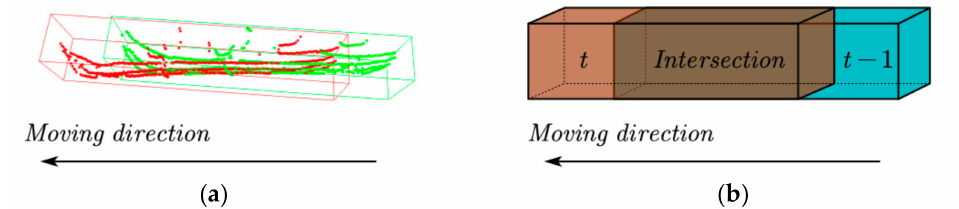
Figure 13. Intersection of a moving object. ( a ) The intersection of the two sequence frames of point cloud data; ( b ) The intersection formed by the axis-aligned bounding box.